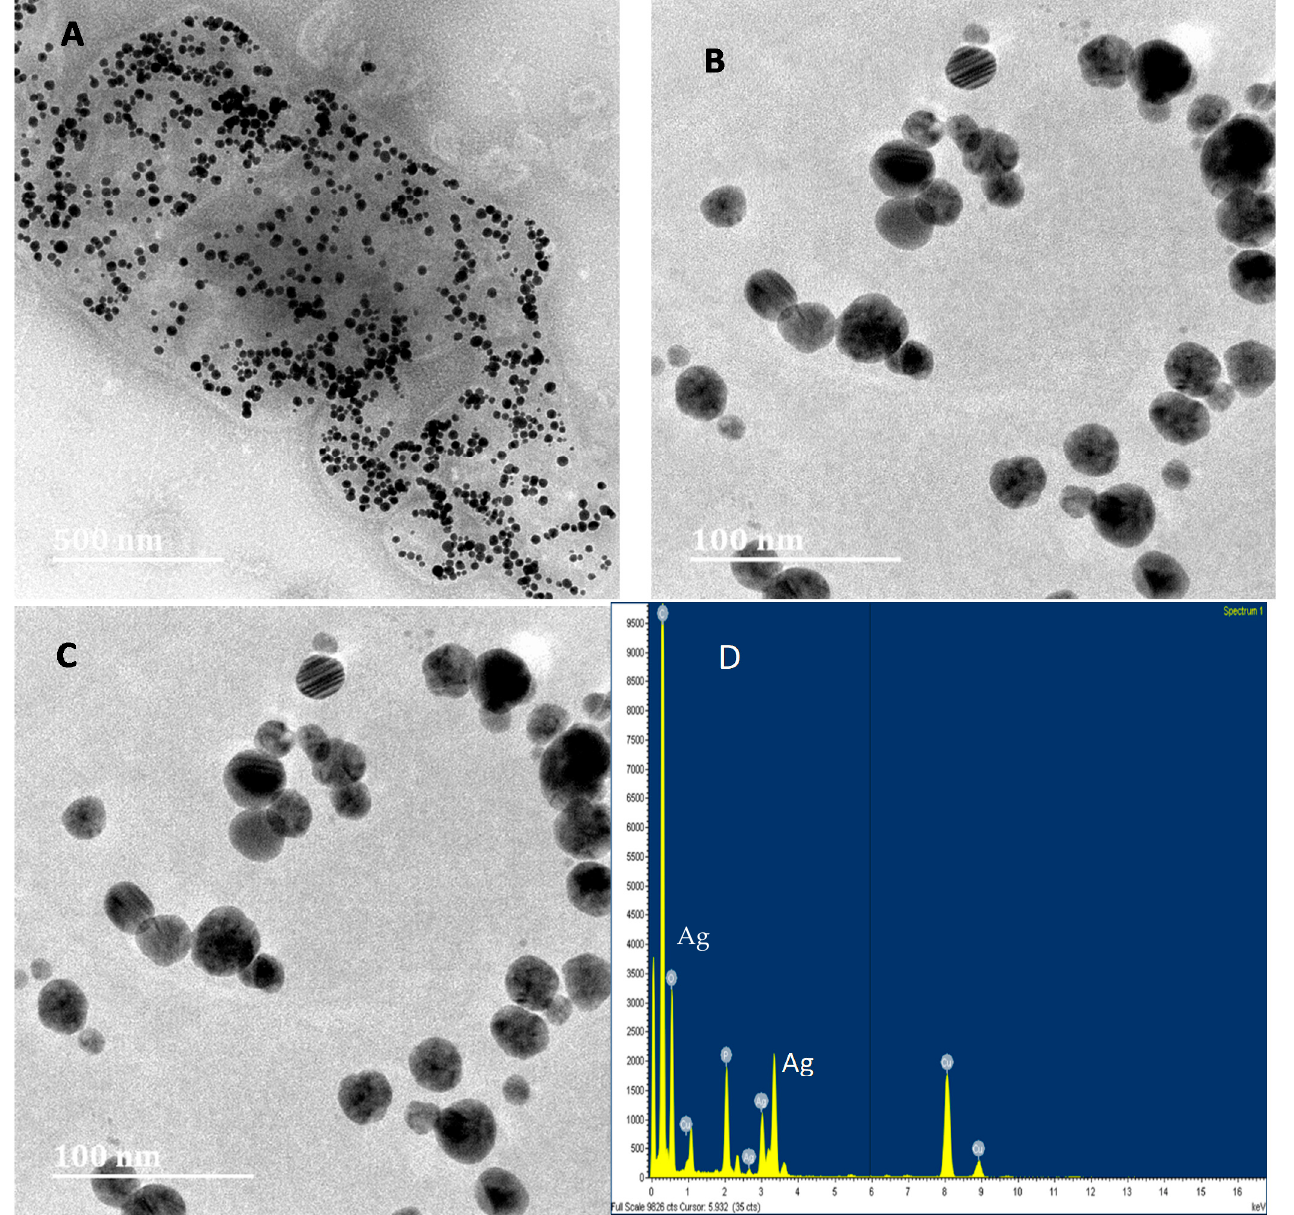
Figure 2. Analysis of biological synthesis of silver nanoparticles. TEM images of Magnetospirillum magnetotacticum with silver nanoparticles ( A ), silver nanoparticles ( B ), lattice fringes ( C ) and EDX pattern ( D ).